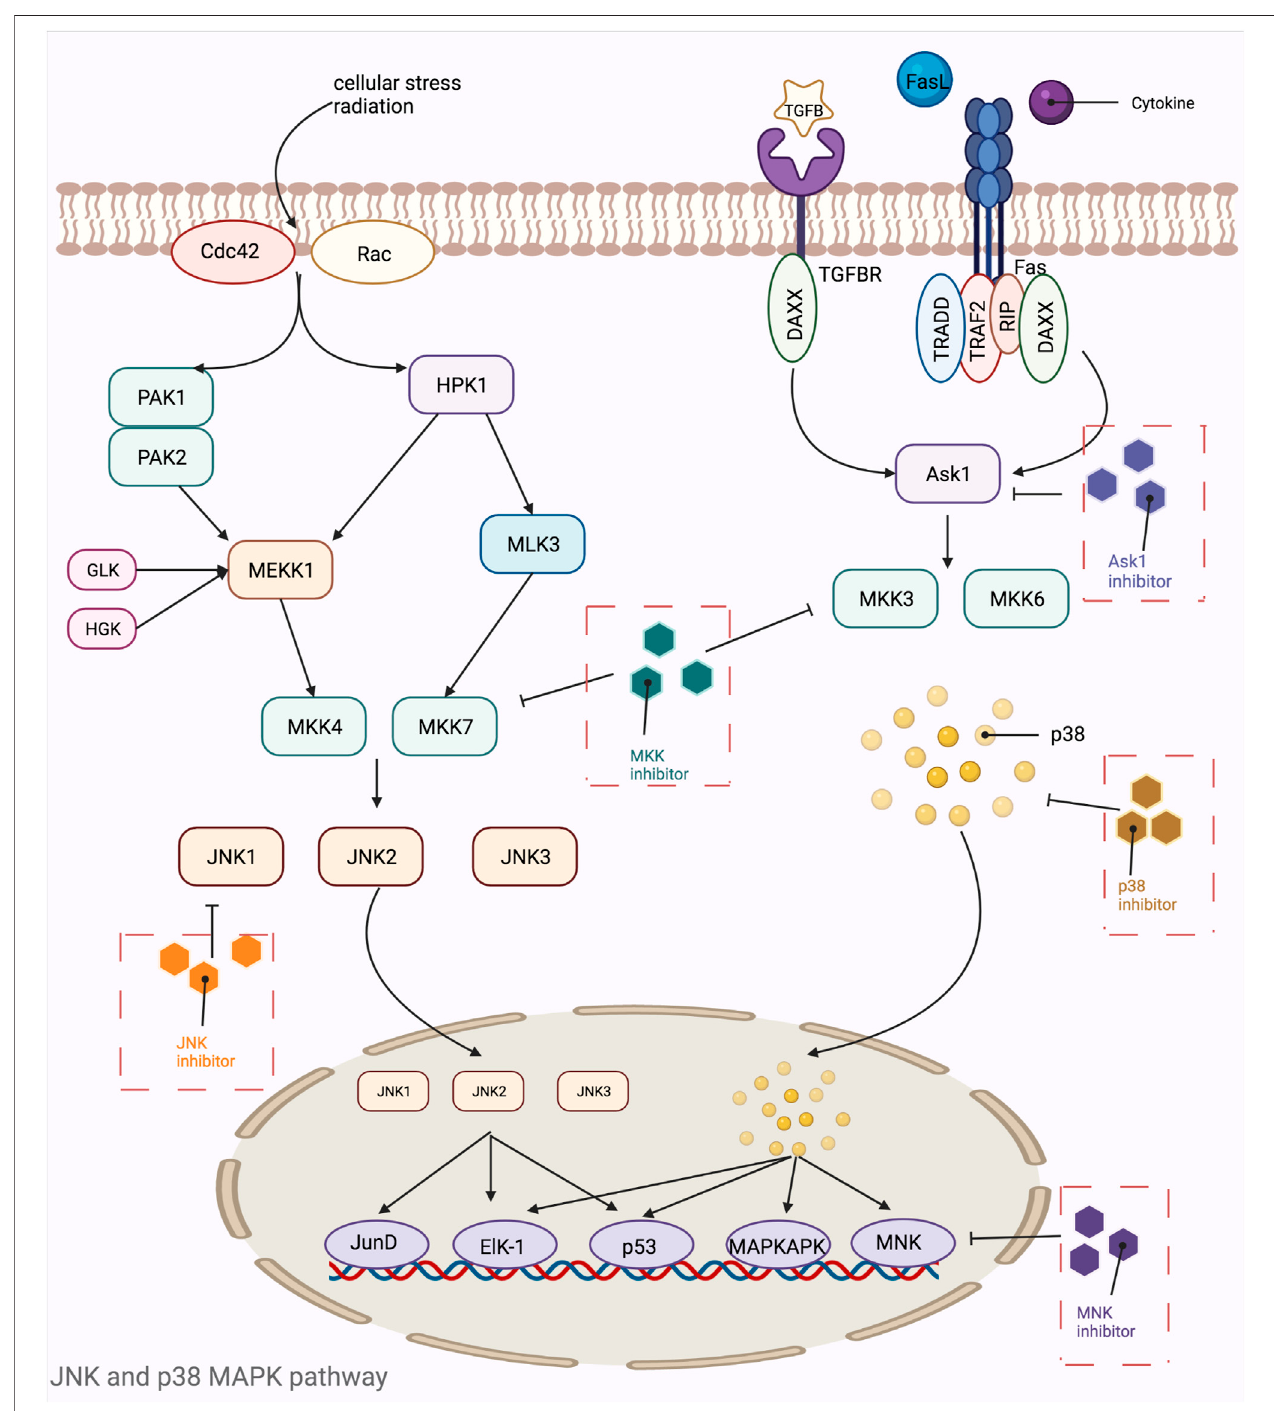
FIGURE6| MechanisticmapoftheJNKandp38MAPKsignalingpathway.Ask1, apoptosissignal-regulatingkinase1;Cdc42,celldivision cycle42;DAXX,death domain-associated protein; Elk-1, ETS domain-containing protein Elk-1; Fas, fatty acid synthase; GLK, glucokinase; HGK, human glandular kallikrein; HPK, histidine protein kinases; JNK, c-Jun N-terminal kinase; MAPKAPK, mitogen activated protein kinase activated protein kinase; MKK, mitogen-activated protein kinase kinase; MLK, mixed lineage kinase; MNK, mitogen-activated protein kinase interacting kinase; PAK, p21-activated kinase; Rac, Ras-related C3 botulinum substrate; RIP, receptor-interacting protein; TGFB, transforming growth factor; TRADD, TNF receptor-associated death domain; TRAF, tumor necrosis factor receptor associated factor. The fi gure is created with BioRender.com.